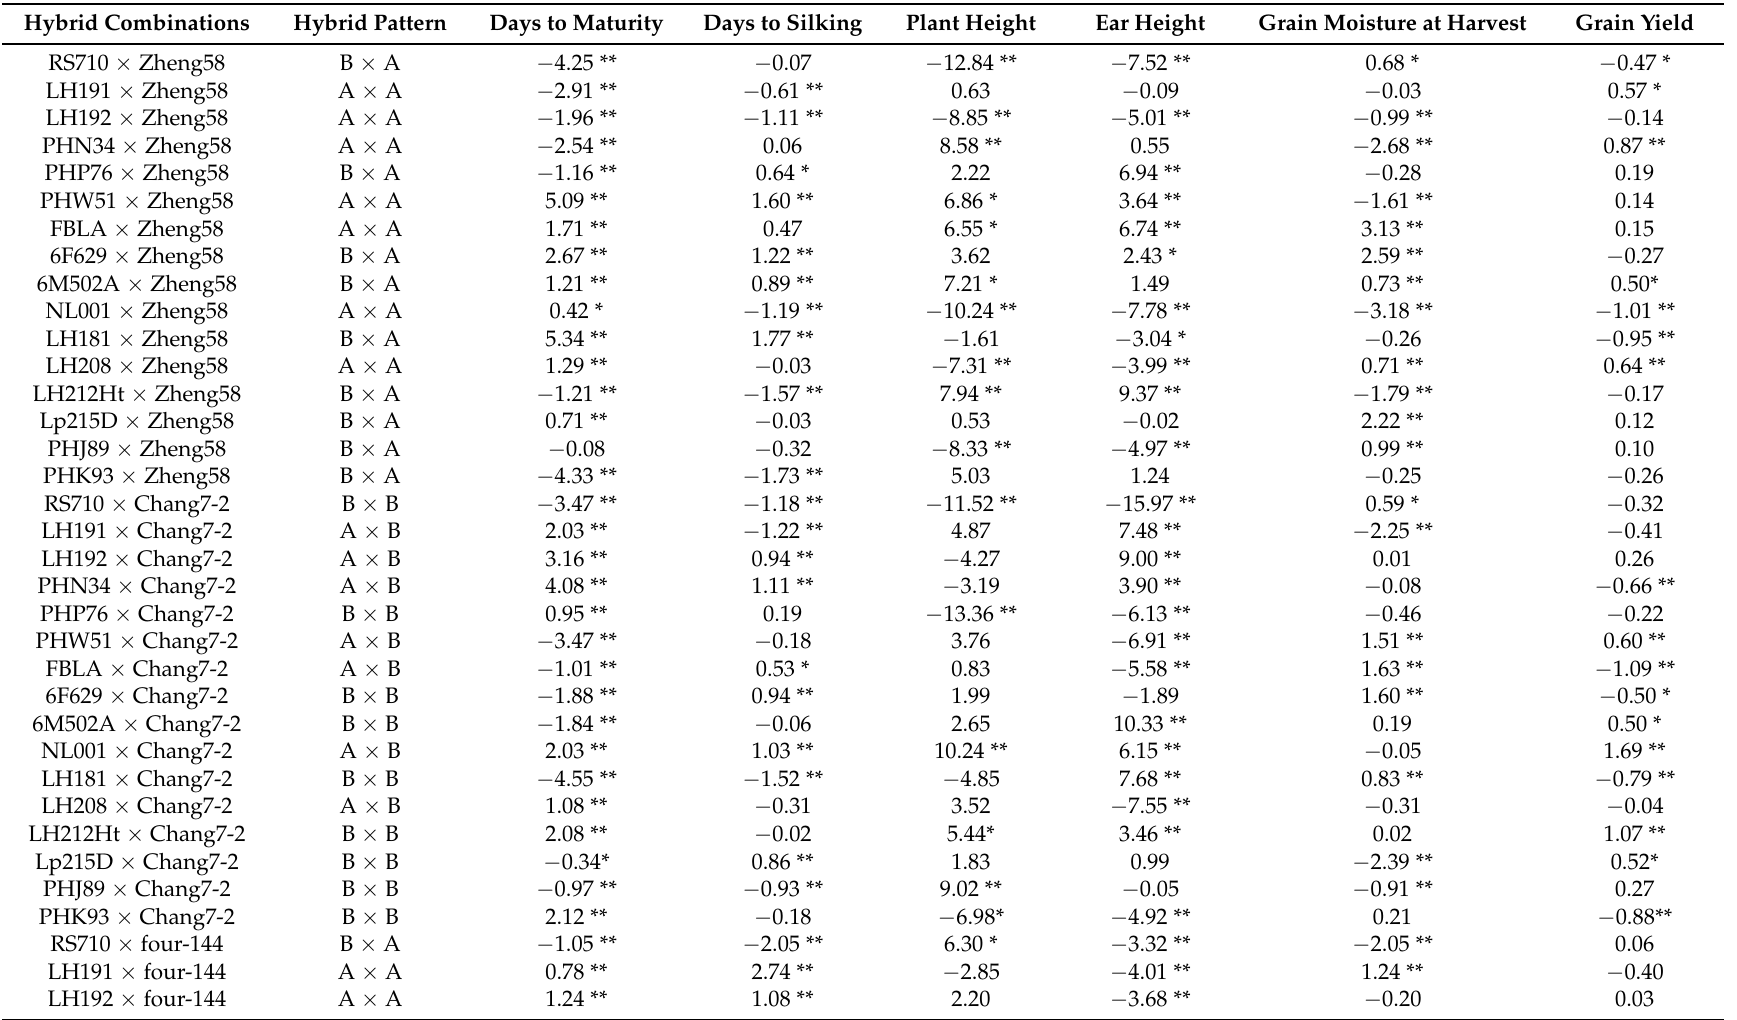
Table 12. Analysis of specific combining ability of hybrid combinations for growth and yield